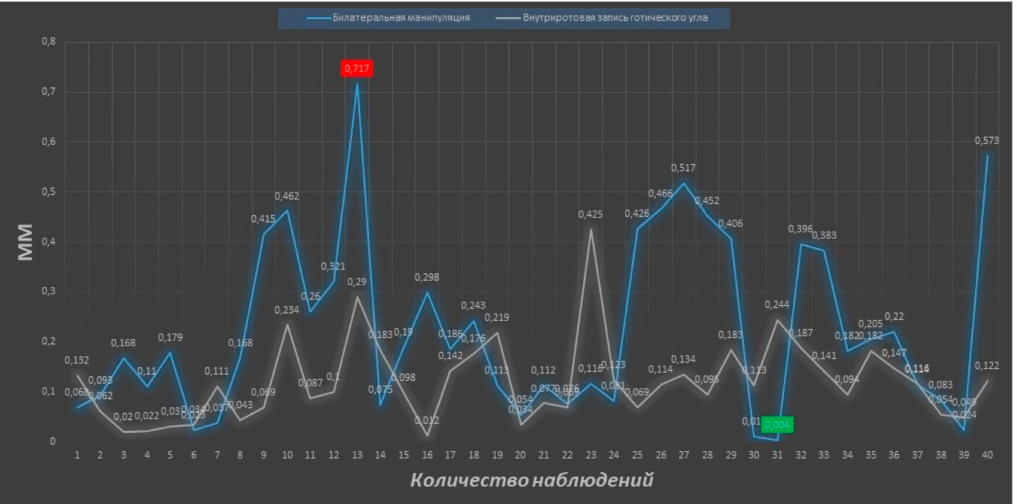
Figure 8. Figure of reproducibility graphic of bilateral manipulation (blue color) and device for recording the gothic angle (grey color). Number of observations at the x-axis, value of deviation in mm at the